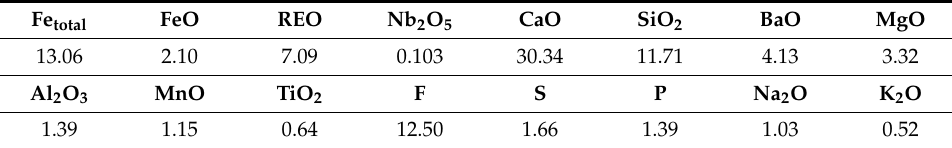
Table 1. Chemical composition of the sample of Bayan Obo tailings (wt. %).